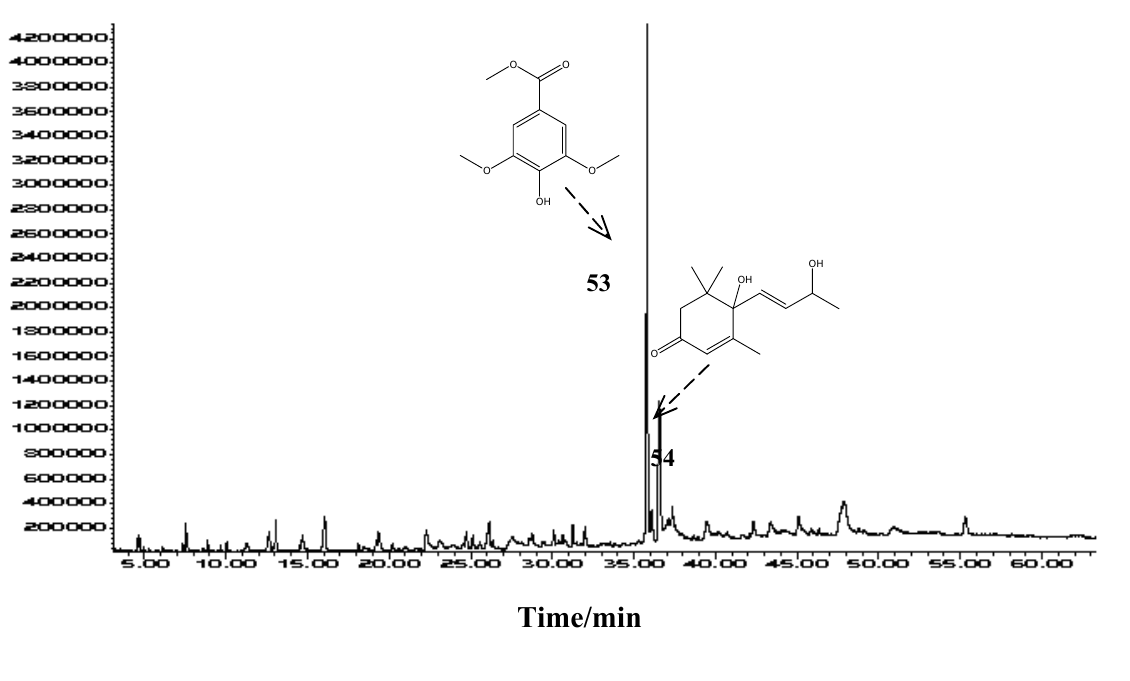
Figure 2. Representative TIC chromatogram of organic extractives obtained with